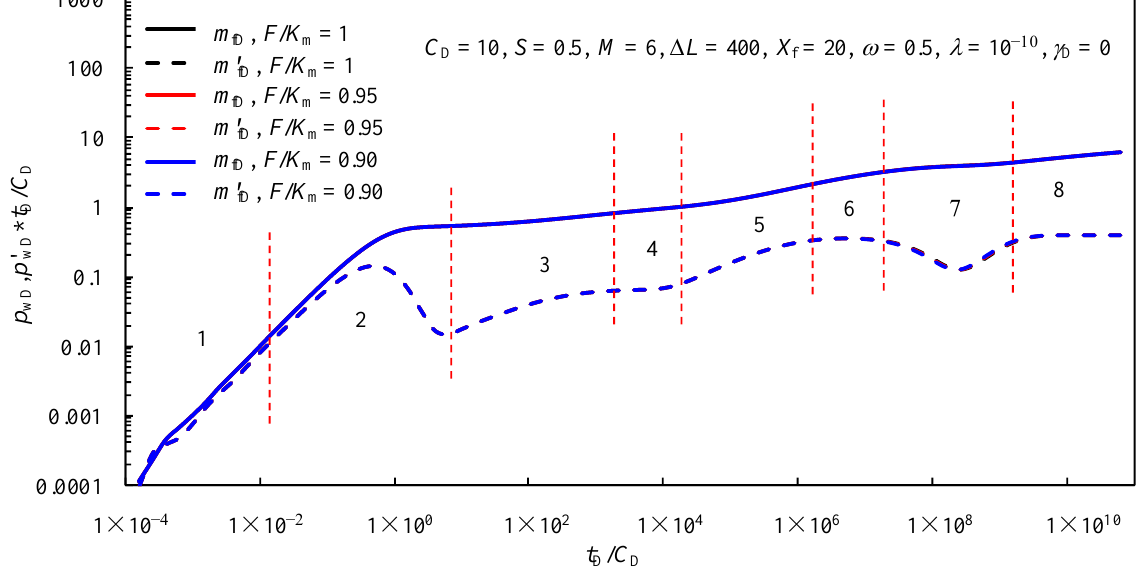
Figure 4. The effect of salt dissolution on the dimensionless pressure and pressure derivatives of a MFHW in an inter-salt shale oil reservoir.